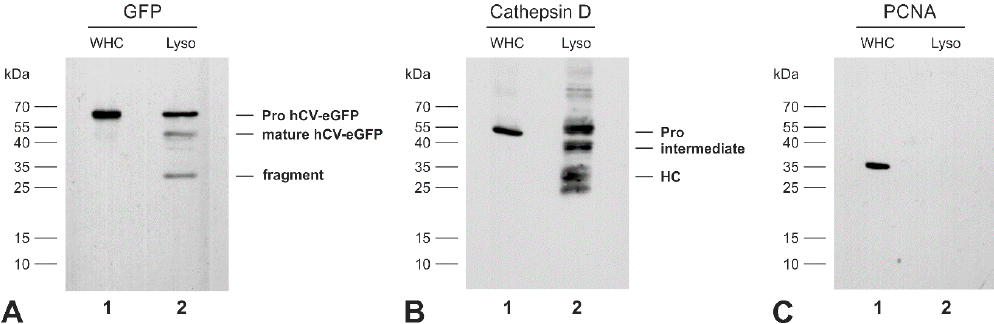
Figure5. PresenceofmaturehCV-eGFPchimericproteinwithinendo-lysosomalfractions. Immunoblots of lysates prepared from whole cells (WHC, lanes 1, respectively) or endo-lysosome enriched fractions (Lyso, lanes 2, respectively) of Nthyori-CV cells were probed with anti-GFP ( A ), anti-cathepsin D ( B ), and anti-PCNA antibodies ( C ), respectively. Molecular mass markers are indicated in the left margins ( A – C ). Only the proforms (pro) of hCV-eGFP and cathepsin D were detected in the whole cell lysates of Nthyori-CV cells (( A , B ), lanes 1, respectively). In addition to the proform, the endo-lysosomal fractions of Nthyori-CV cells contained the processed mature form of hCV-eGFP and its degradation fragment (( A ), lane 2). The molecular forms of cathepsin D, i.e., proform (Pro), intermediate, and heavy chain of two-chain cathepsin D (HC), were detected in the endo-lysosomal fractions (( B ), lane 2). Immunoblotting with anti-PCNA antibodies confirmed the purity of the endo-lysosomal fractions ( C ). 2.5. The Chimeric Protein hCV-eGFP Is Secreted from Thyroid Epithelial